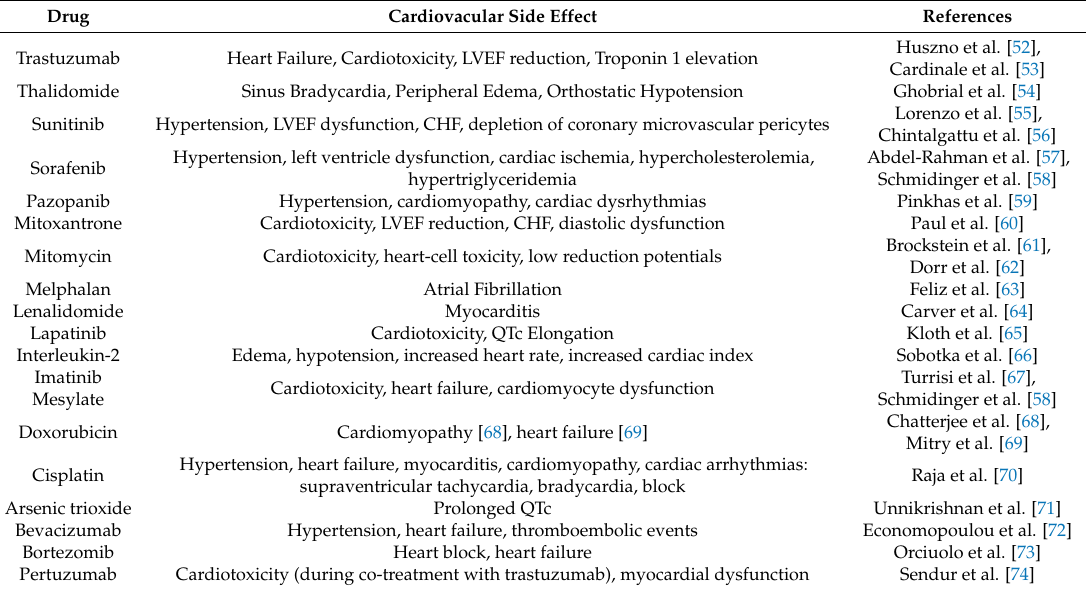
Table 1. Chemotherapeutic agents with known cardiovascular